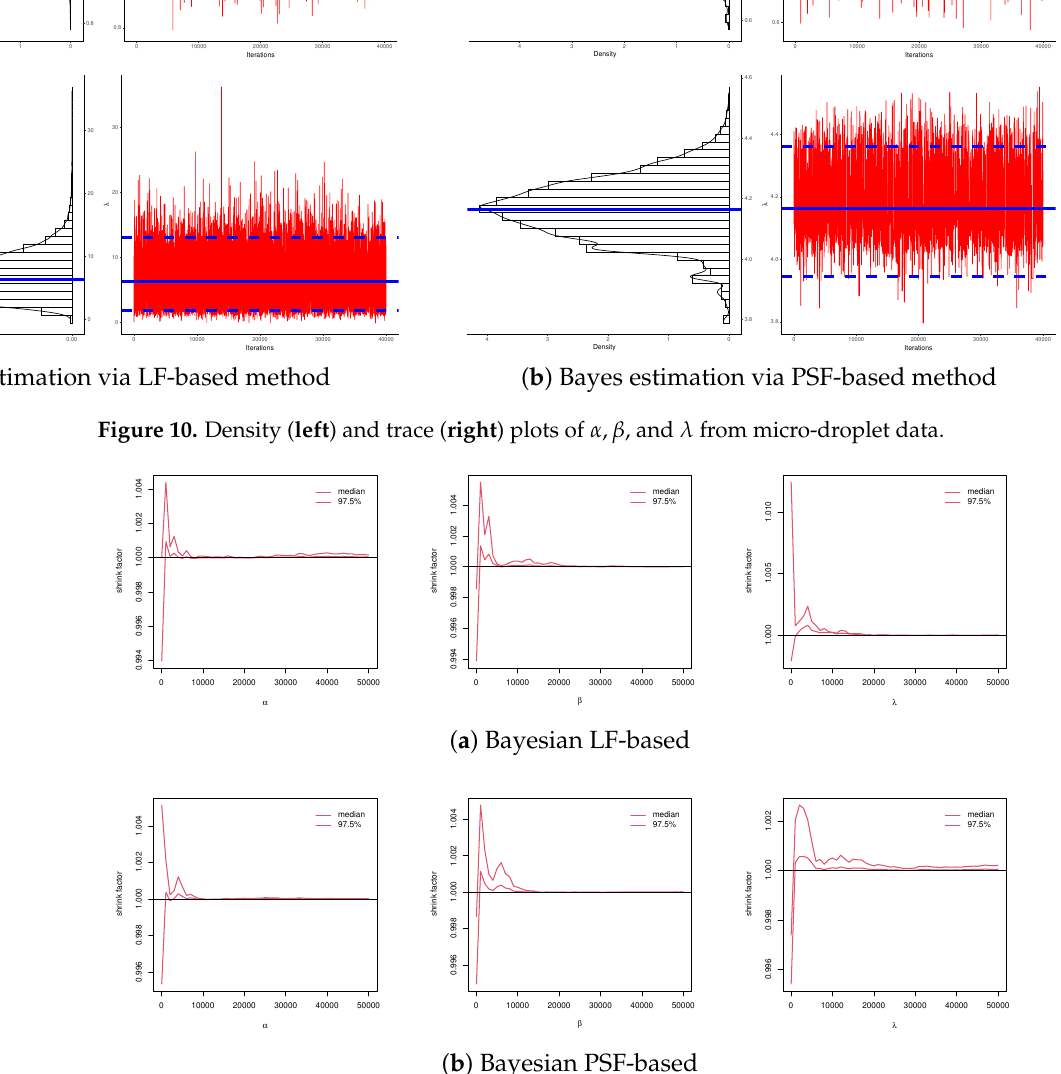
Figure 11. The BGR diagnostic for MCMC draws of α , β , and λ from micro-droplet